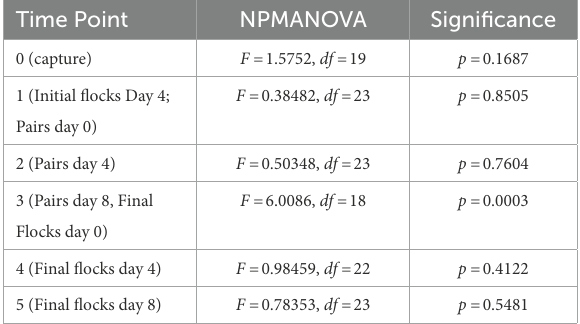
TABLE 3 Non-parametric multivariate of variance (NPMANOVA) analysis of volatile profile differences between flocks at each time point of the